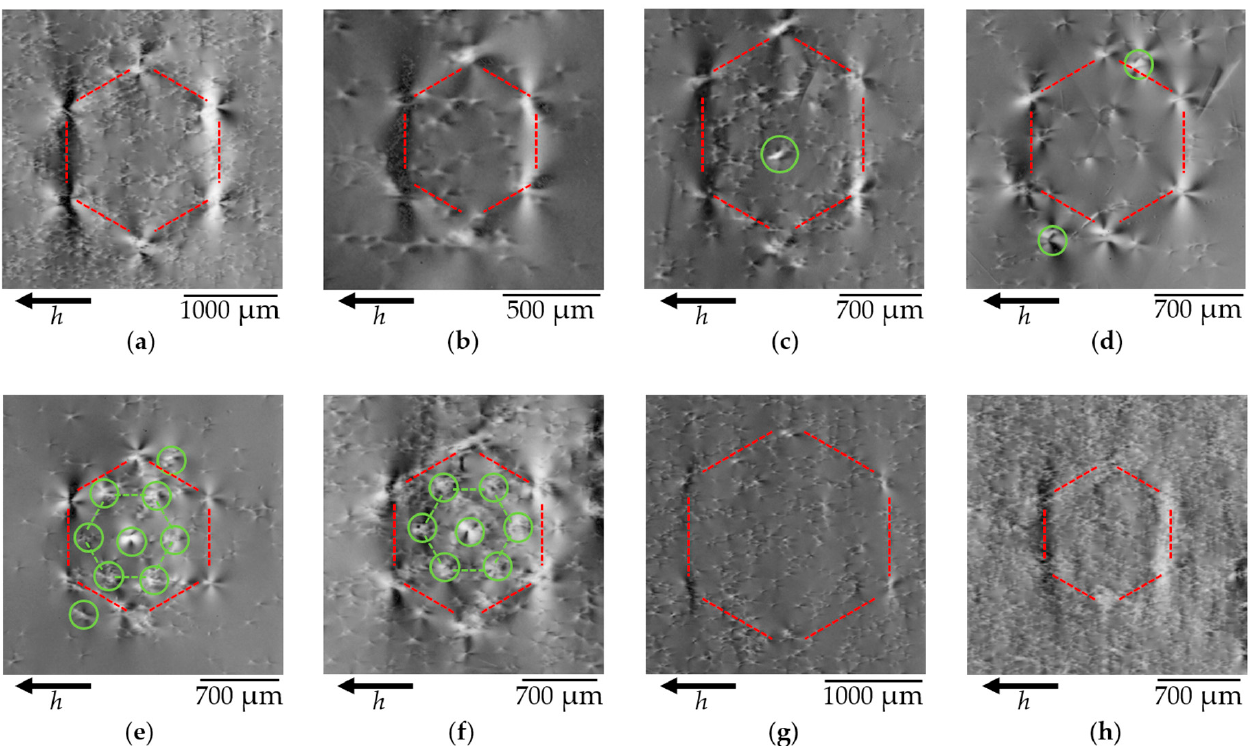
Figure 5. L-XRT of eight different HCDs (marked with a red hexagon for better visibility), which exhibit different sizes and different contrasts with light and dark areas arranged hexagonally, as well as often large many-lobed rosettes. All topographs were measured using a type 1120 reflection. Additional clusters of threading dislocations are indicated by blue circles; the green hexagons mark (cid:8) (cid:9) m -planes. ( a ) HCD with strong contrast a second kind of honeycomb bounded by the six 1100 rosettes in semi-insulating Am-GaN, ( b ) HCD with strong contrast rosettes in n-type Am-GaN, ( c – f ) HCDs with in addition to the six rosettes that form the hexagon, other rosettes marked by small blue circles, ( e , f ) HCDs with six additional rosettes that form a second hexagon (marked in green), ( g , h ) HCDs with weak contrast rosettes in semi-insulating